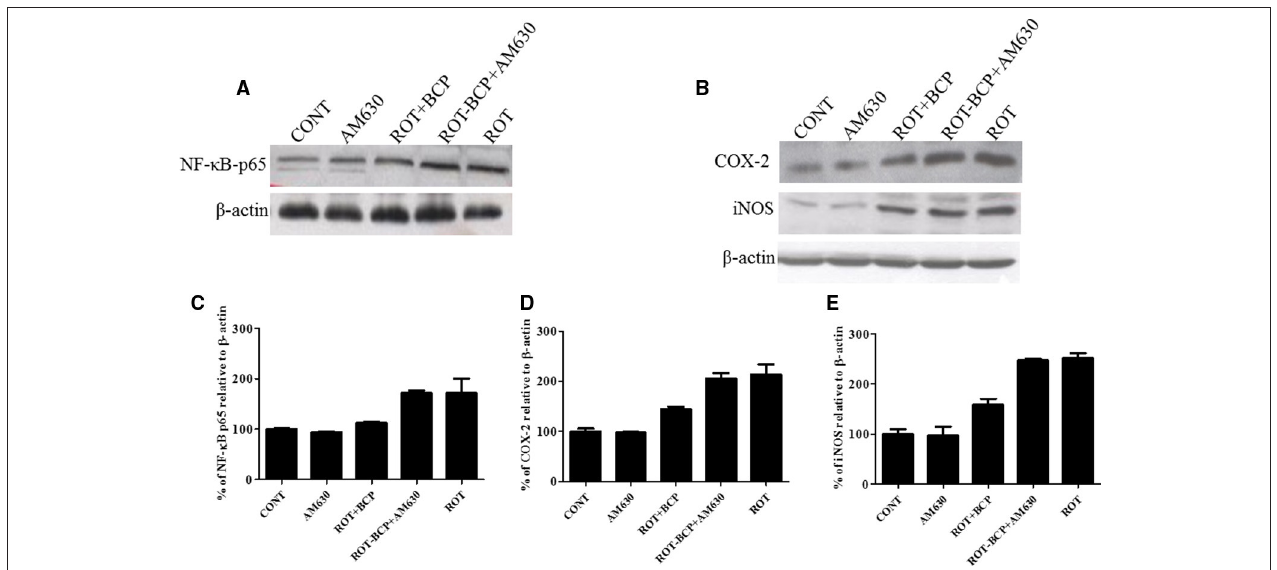
FIGURE 7 | Western blot analysis of NF- κ B p65, COX-2, and iNOS in the striatal tissue. Values are expressed as percent (%) mean ± SEM ( n = 3). Expression level of NF- κ B p65 (A) COX-2 and iNOS (B) was carried out by western blot. (C) ROT-administered group rats showed increase in nuclear NF- κ B p65 level as compared to control group (171.7 vs. 100% control). BCP treatment of the ROT-challenged rats decreased the NF- κ B p65 expression when compared to the ROT group (112.38 vs. 171.7%). The ROT-BCP + AM630 group had shown increased expression of NF- κ B p65 as compared to the ROT + BCP group (171.55 vs. 112.38%). (D) ROT-injected rats showed increased COX-2 level as compared to the CONT rats (213.48 vs. 100% control). BCP supplementation to ROT-injected rats showed decreased expression of COX-2 as compared to ROT group rats (143.6 vs. 213.48%). ROT-BCP + AM630 group rats showed increase in COX-2 expression as compared to the ROT + BCP group rats (205.6 vs. 143.6%). (E) Likewise, iNOS expression was increased in the ROT group rats as compared to the CONT group rats (251.56 vs. 100% control). BCP treatment decreased iNOS expression as compared to the ROT group rats (158.12 vs. 251.56%). The ROT-BCP + AM630 group showed increase in iNOS expression when compared to the ROT + BCP group (247.18 vs.